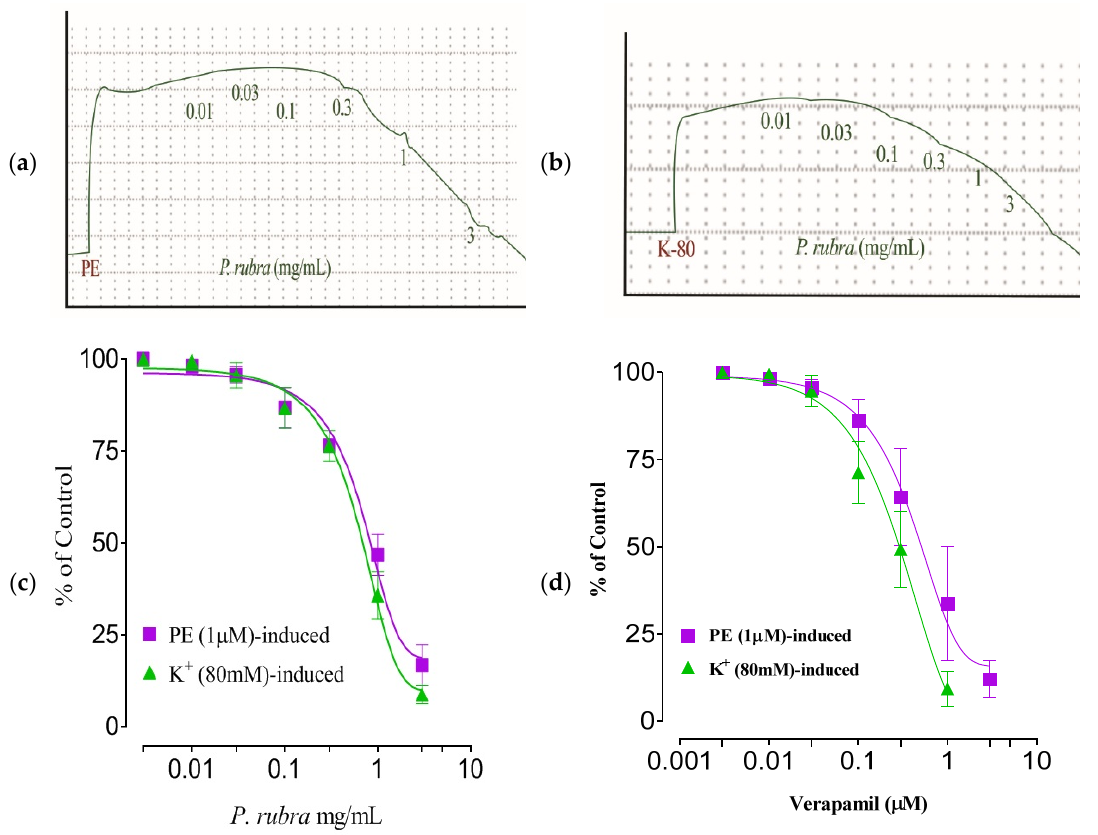
Figure 7. Tracings of aqueous-methanolic leaf extract of P. rubra against PE (1 µM)-induced contrac- in rabbit aorta strip ( a ); K + (80 mM) induced contraction ( b ); vasorelaxing dose–response curve of tion in rabbit aorta strip ( a );K + (80 mM ) induced contraction ( b ); vasorelaxing dose–response curve P. rubra ( c ); and verapamil ( d ) against PE (1 µ M) and K + (80 mM)-induced contractions). All the of P. rubra ( c ); and verapamil ( d ) against PE(1 µM)and K + (80 mM )- induced contractions). All the values ( n = 5) are depicted as mean ± values ( n =5) are depicted as mean ± SEM.